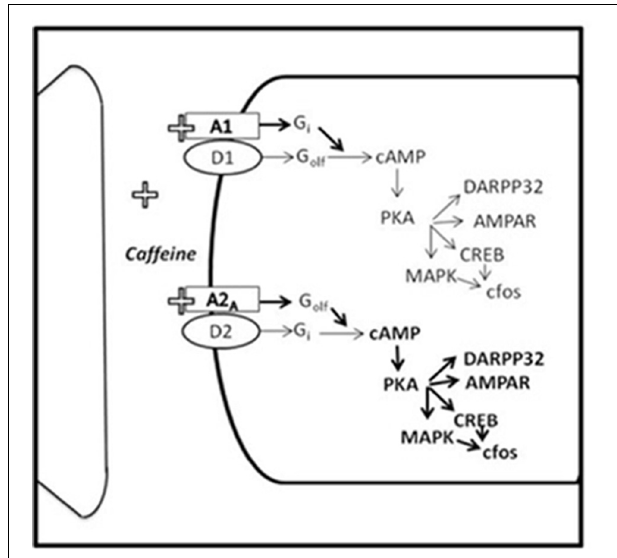
FIGURE 1 | Impact of caffeine on the functional interaction between adenosine and DA receptors. A 1 R and A 2A R, adenosine A 1 and A 2A receptors; D 1 , DA type 1 receptor; D 2 , DA type 2 receptor (adapted from Ferré,